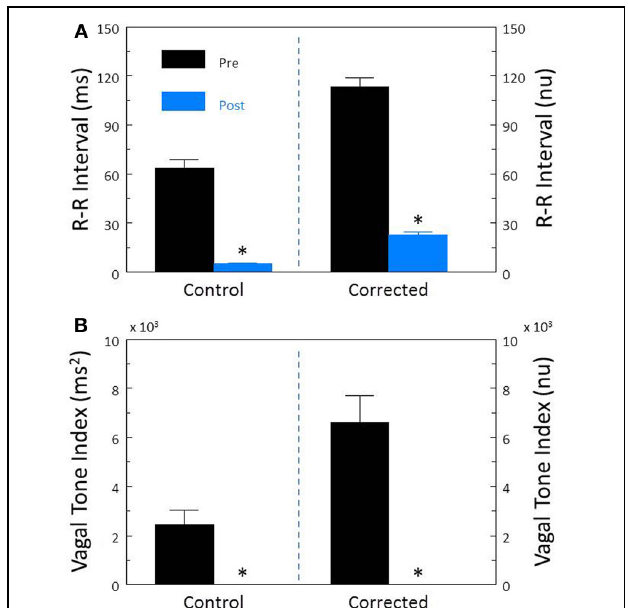
FIGURE 6 | The effect of total autonomic neural inhibition on heart rate variability. Cardiac autonomic blockade ( n = 25) was achieved using the combination of a cholinergic receptor antagonist (atropine sulfate, 50 μ g/kg i.v.) and a non-selective β -adrenergic receptor (propranolol HCl, 1.0mg/kg i.v.). The effects of autonomic blockade on total heart rate variability (standard deviation of R-R interval, RRSD) without and with correction (RRSD/mean RRsec) are displayed in (A) . The effects of this treatment on the high frequency variability (cardiac vagal tone index, 0.24–1.04 Hz) without and with correction [cardiac vagal tone/(mean RRsec) 2 ] are shown in (B) . Note that despite correction for large increases in heart rate, this treatment still provoked large reductions in both RRSD and the cardiac vagal tone index. As baseline HR increased following autonomic blockade, these data indicate the presence of a tonic parasympathetic restraint of intrinsic HR under basal conditions in the dog. ∗ P < 0 . 01 pre (black bars) vs. post (blue bars); pre = last 30s before atropine + propranolol administration, post = 30s interval recorded 5min after this drug treatment. nu, normalized units following HR